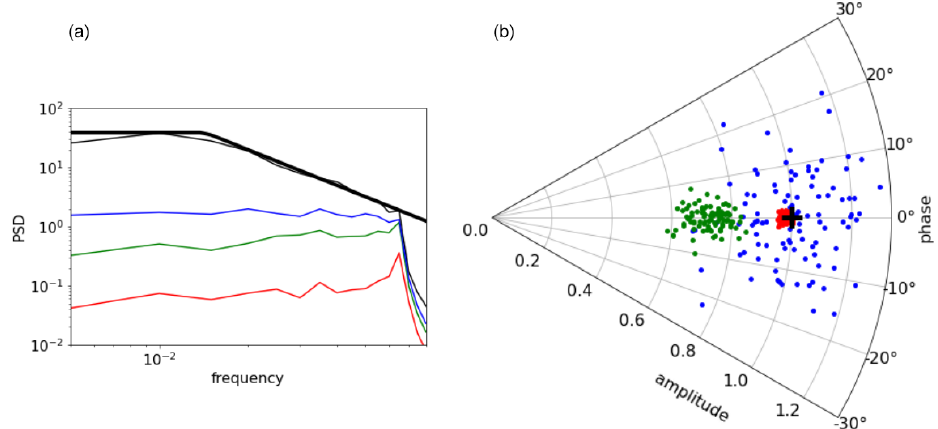
Figure 2. (a) Mean (averaged over the 100 realizations) power spectral densities of the LFC ground truth (thin black) and the LFC estimation error (estimation minus ground truth) for all three estimations (independent, sequential and simultaneous in blue, green and red, respectively). The thick black curve represents the theoretical LFC ground-truth spectrum. (b) Amplitude and phase (in the complex domain) of the high frequency component (HFC), represented by the black cross for the ground truth, and by the green, blue and red points for the 100 realizations of the independent, sequential and simultaneous estimations,